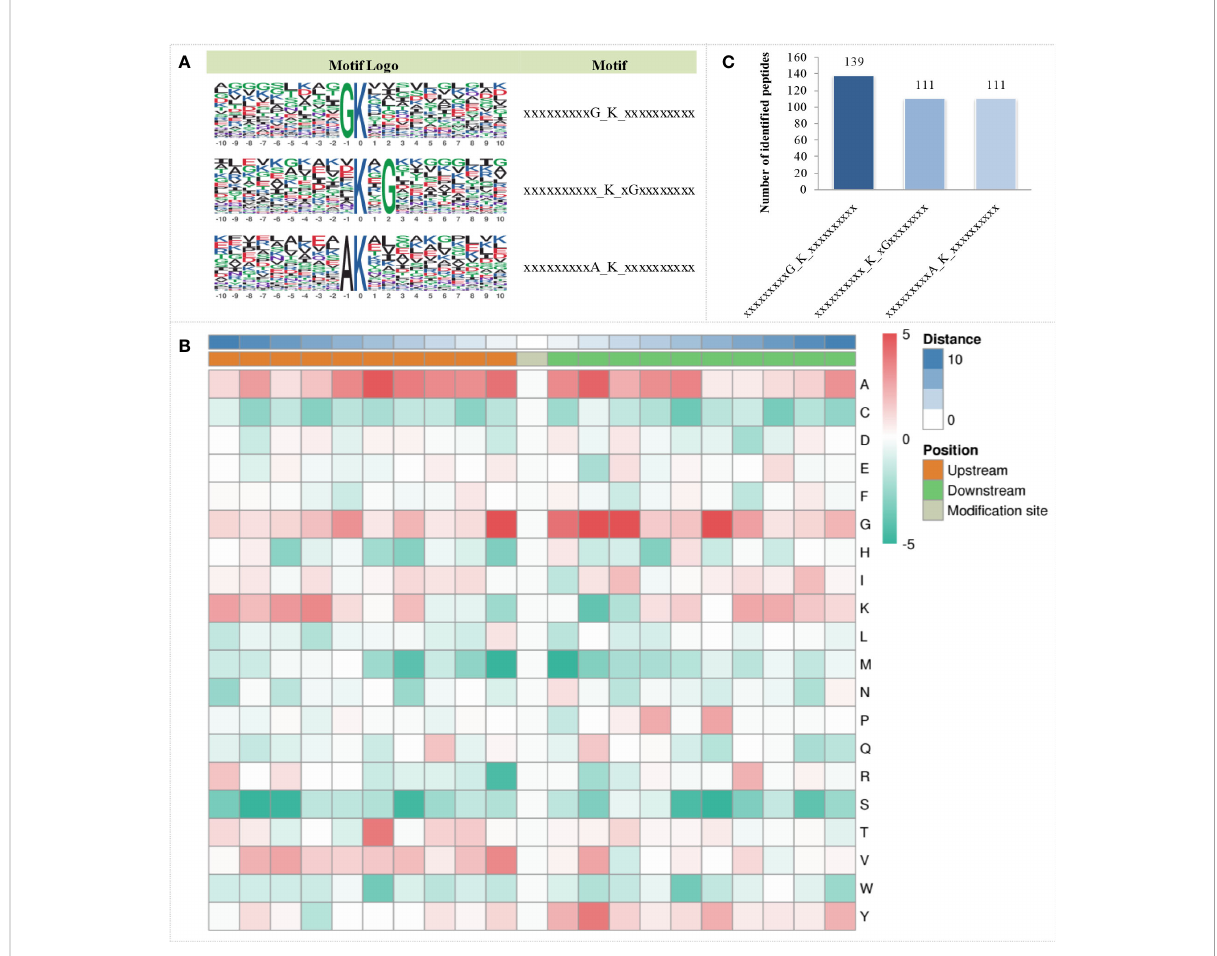
FIGURE 3 Sequence characteristics of succinylation proteins under OBZ treatment in pakchoi leaves. Analysis of the conserved motifs of succinylation proteins (A) , number of identi fi ed peptides containing the indicated succinylation motifs (B) , and characterization of amino acid sequences around the succinylation sites (C)